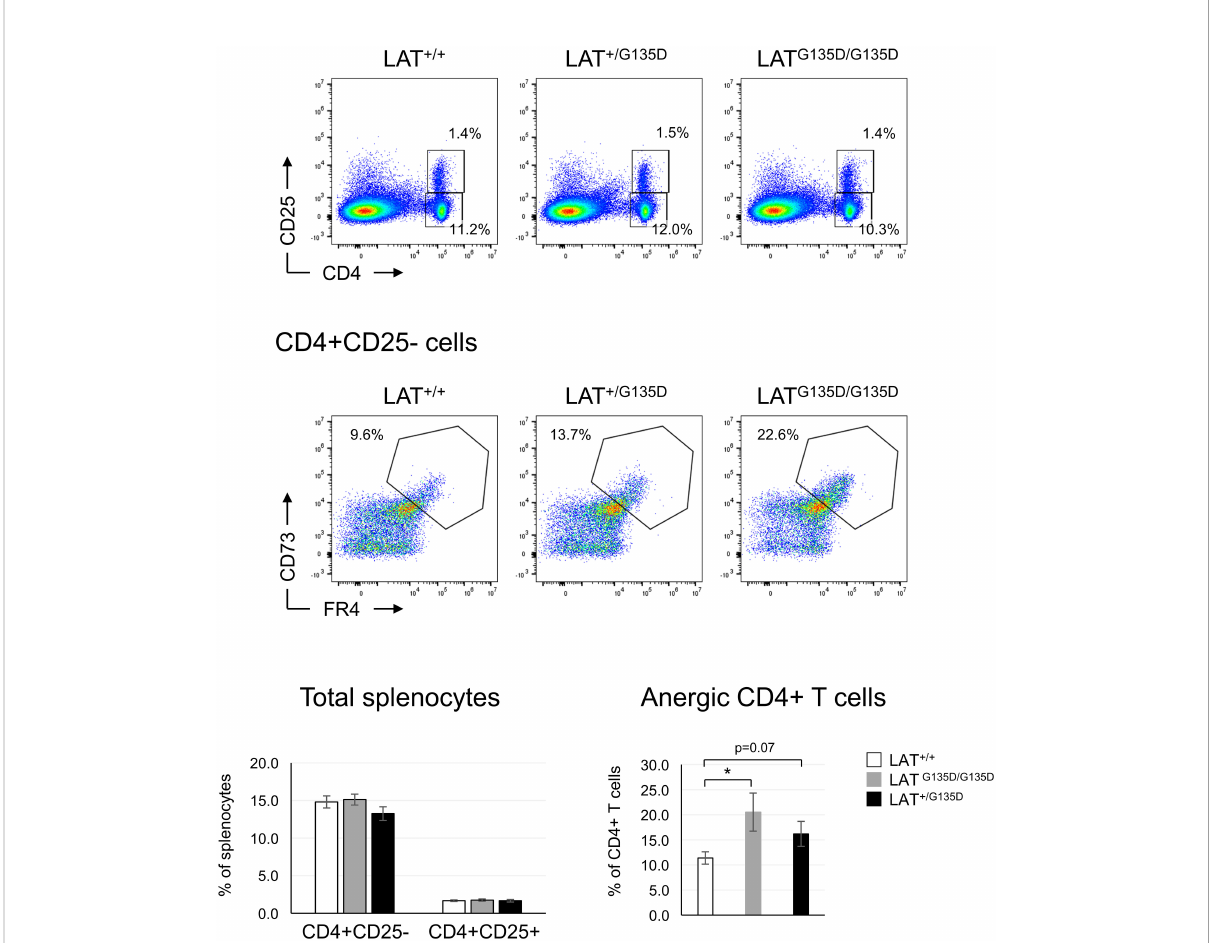
FIGURE 3 LAT G135D mutation increases the percentage of anergic T cells. Splenocytes from the indicated types of mice were stained with CD4 and CD25 speci fi c monoclonal antibodies (upper dot plots). The numbers indicated in each gate represent the percentage of CD4 + CD25 - and CD4 + CD25 + cells. Middle panels: CD4 + CD25 - cells were analyzed for the expression of CD73 and FR4, and the percentage of anergic T cells is indicated. Lower bar graphs: average of the indicated populations after the analysis of LAT +/+ (n = 13), LAT +/G135D (n = 8) and LAT G135D/G135D (n = 12) mice. The brackets on each bar represent the mean standard error. * indicates